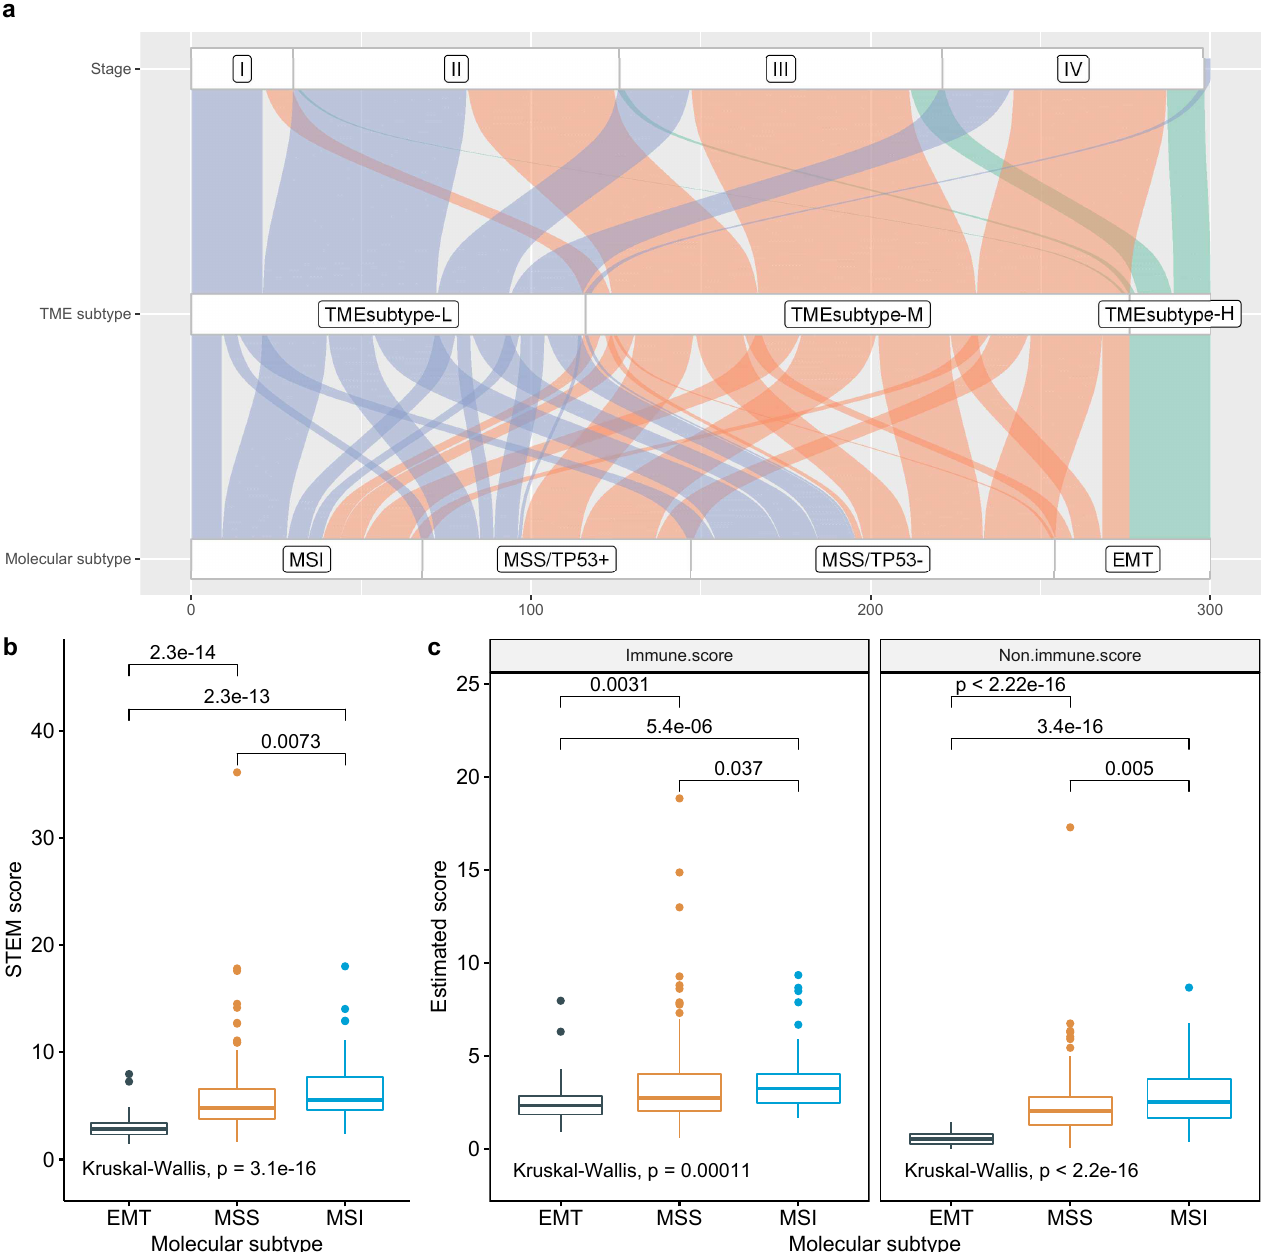
Figure 20. Association of TME subtypes and ACRG molecular subtypes. ( a ) Alluvial plot displaying the association of TME subtypes, ACRG molecular subtype, and stage. ( b ) Comparison of STEM score across three ACRG molecular subtypes. ( c ) Comparison of non-immune (e.g., ratio of EMEC/stromal cell) and immune scores (e.g., ratio of T adaptive/monocytes) across three ACRG molecular